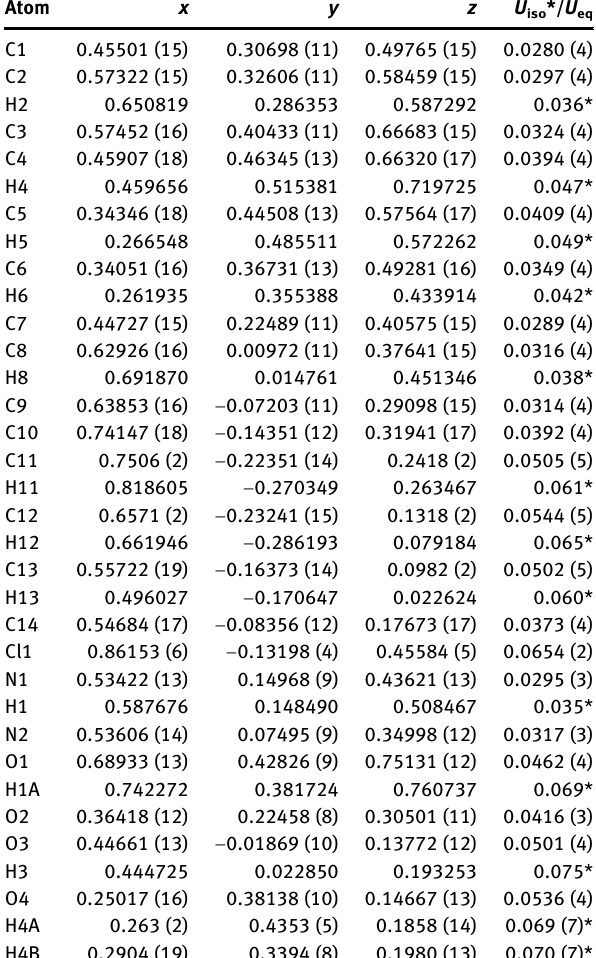
Table  : Fractional atomic coordinates and isotropic or equivalent isotropic displacement parameters (Å 